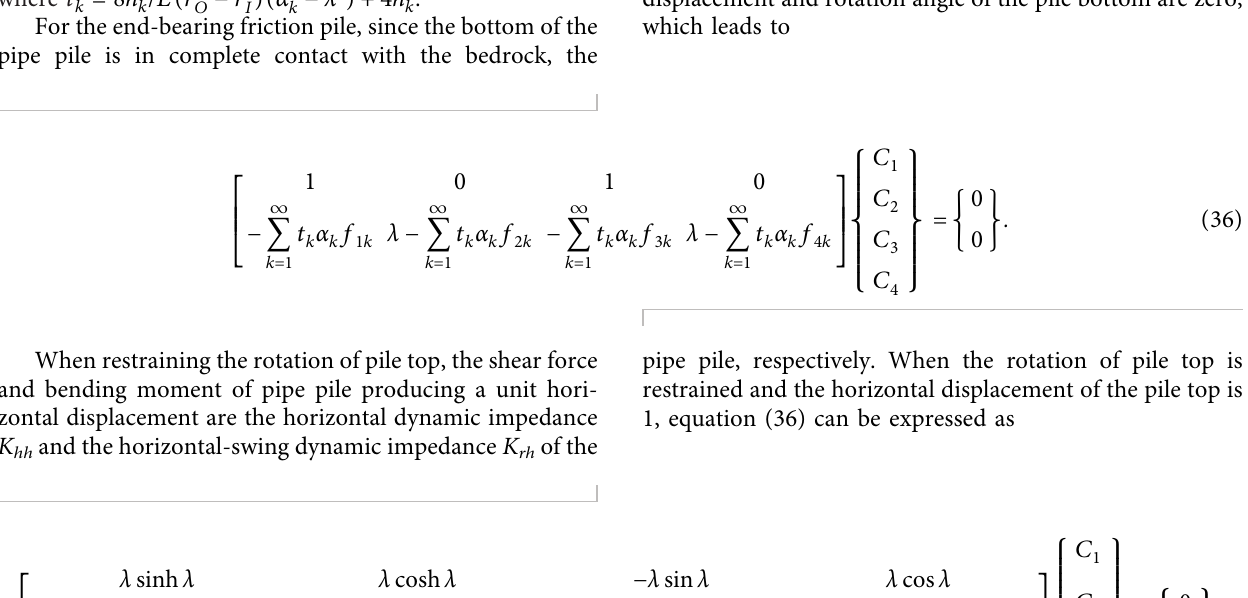
Figure 6: The impedance factor curves of soil layers under different model parameters ( T (b) Horizontal damping factor of the soil